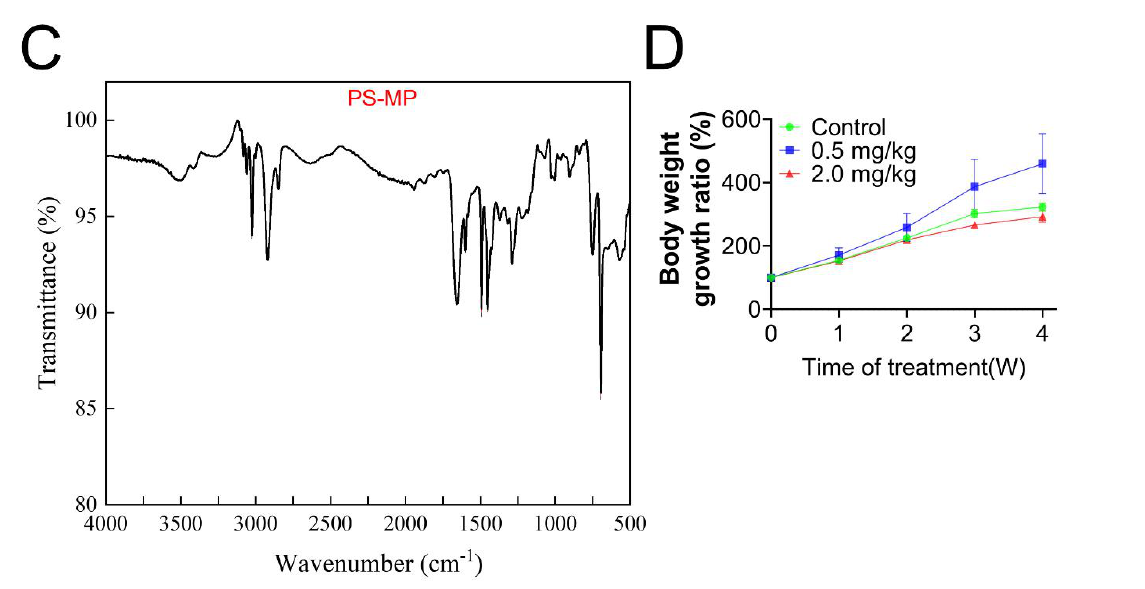
Figure 1. Characterization of PS-MPs by SEM, DLS, and FTIR. ( A ) PS-MP morphology (scale bar = 5 μm). ( B ) Hydrodynamic size distribution of PS-MPs. ( C ) FTIR image of PS-MP. ( D ) Body weight growth ratio.